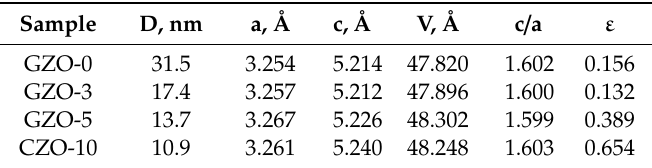
Table 1. Crystallites size (D), the wurtzite ZnO lattice parameters (c & a), cell volume (V), average values of the strain ( ε ) along the c-axis and (c / a) ratio for Ga doped ZnO samples and the ratio between the intensity of the FTIR absorption bands of OH to